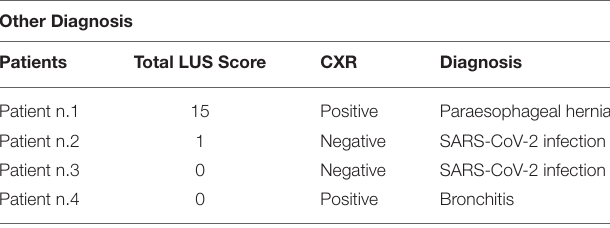
TABLE 3 | Comparison of LUS and CXR results in the cases with other diagnosis.